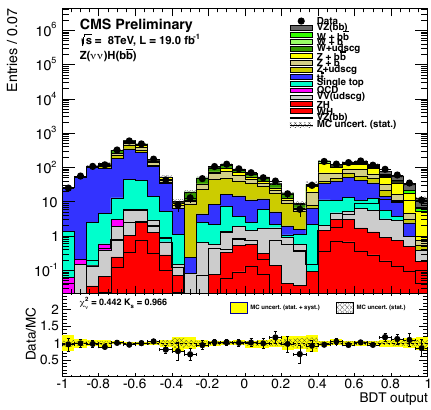
Figure 3. BDT output distribution for Z( ⌫⌫ ) in the high p T (V) bin, for data (points with errors), all backgrounds, and signal.